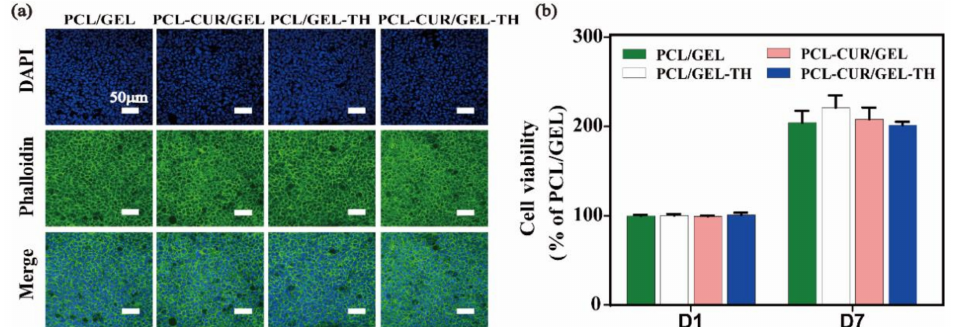
Figure 6. ( a ) Representative images from immunofluorescence staining of HaCaT cells on four different nanofiber membranes after 7-day cell culture. The F-actin cytoskeleton was labeled as green by Alexa Fluor 488 Phalloidin, while the nucleus was labeled as blue by DAPI. ( b ) Cytotoxicity effects of four different coaxial nanofiber mats on human HaCaT